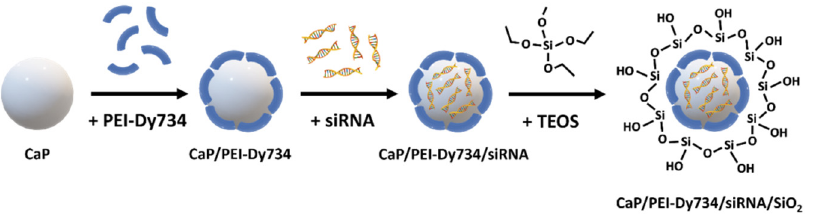
Figure 1. Schematic representation of the synthesis of Dy734-labeled and siRNA-loaded calcium phosphate nanoparticles (CaP/PEI-Dy734/siRNA/SiO 2 ) for in vivo gene silencing of NF- κ B p65 in mice. CaP—calcium phosphate, Dy—Dyomics, PEI—polyethyleneimine, siRNA—small interfering RNA, TEOS—tetraethoxysilane.